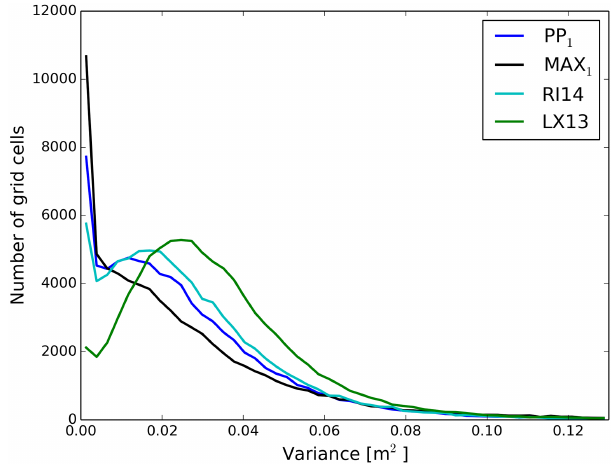
Figure 7. Histograms of grid cell SSH variance from different clas- sifiers. Only values based on at least three lead detections are con-